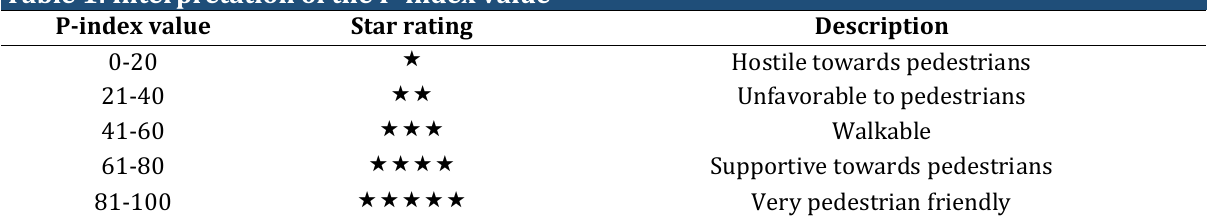
Table 1: Interpretation of the P-index value P-index